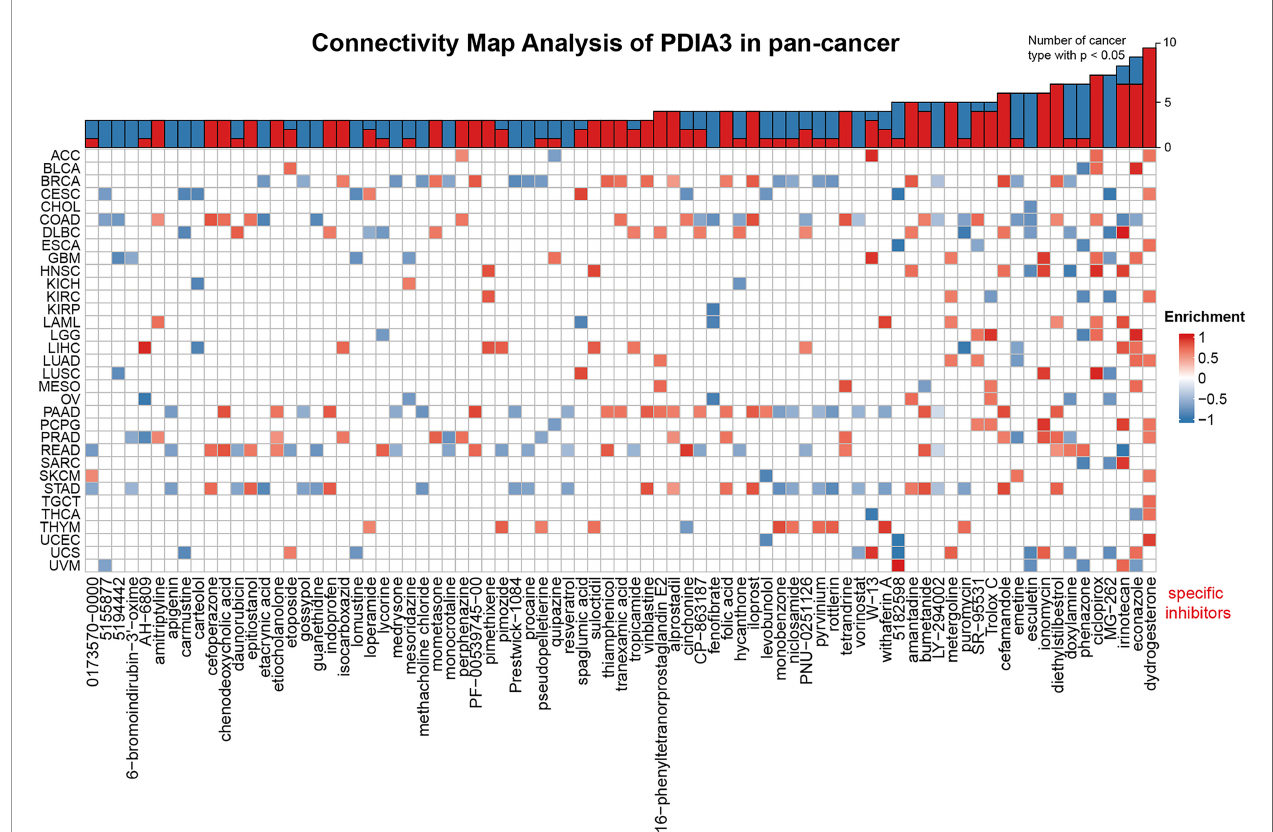
FIGURE 7 | Heatmap representing enriched score (positive in blue, negative in red) of each drug from the CMap database for each cancer. Components or drugs are ordered by decreasing number of enriched cancers from right to